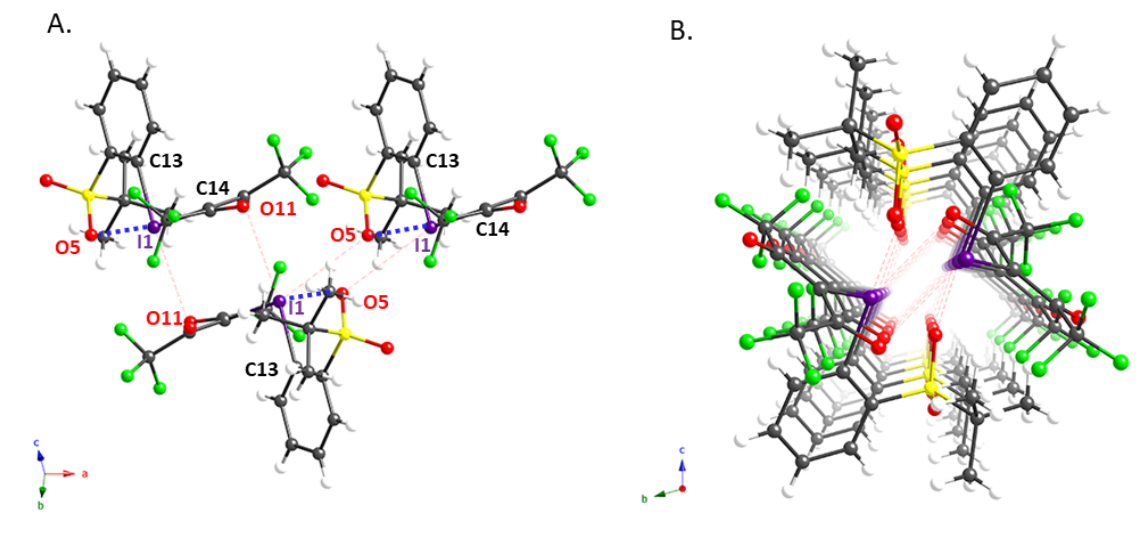
Figure 1. Crystal structure of iodonium ylide 2e : ( A ) sideview of 2e ; ( B ) dimeric columnar structure formed by two stacked columns of 2e .